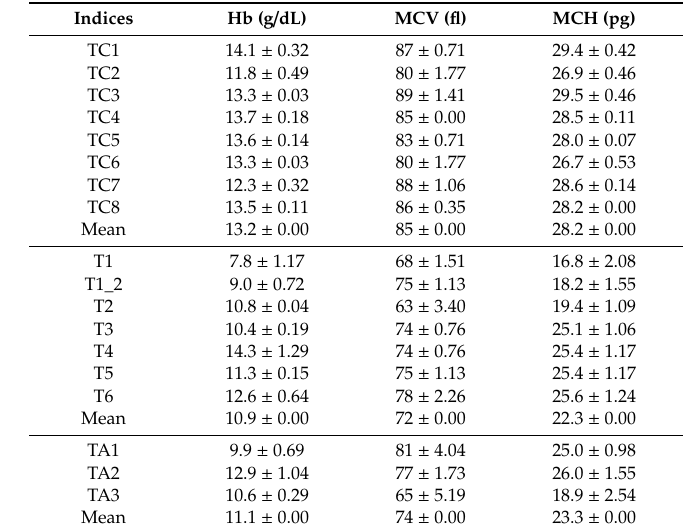
Table 1. Indices for control, thalassemic, and iron-deficient patients: hemoglobin (Hb) in g / dL;